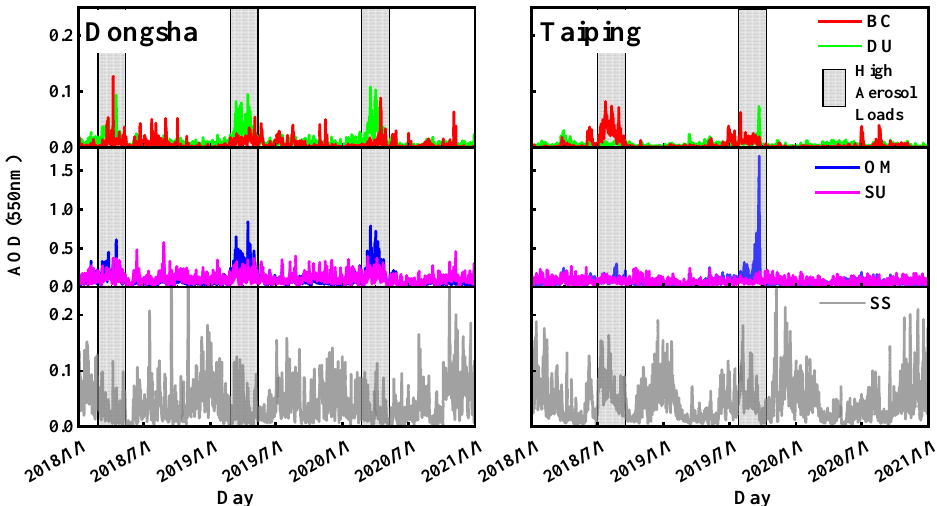
Figure 6. Time evolution of AOD at 550 nm of BC, DU, OM, SU and SS obtained from EAC.